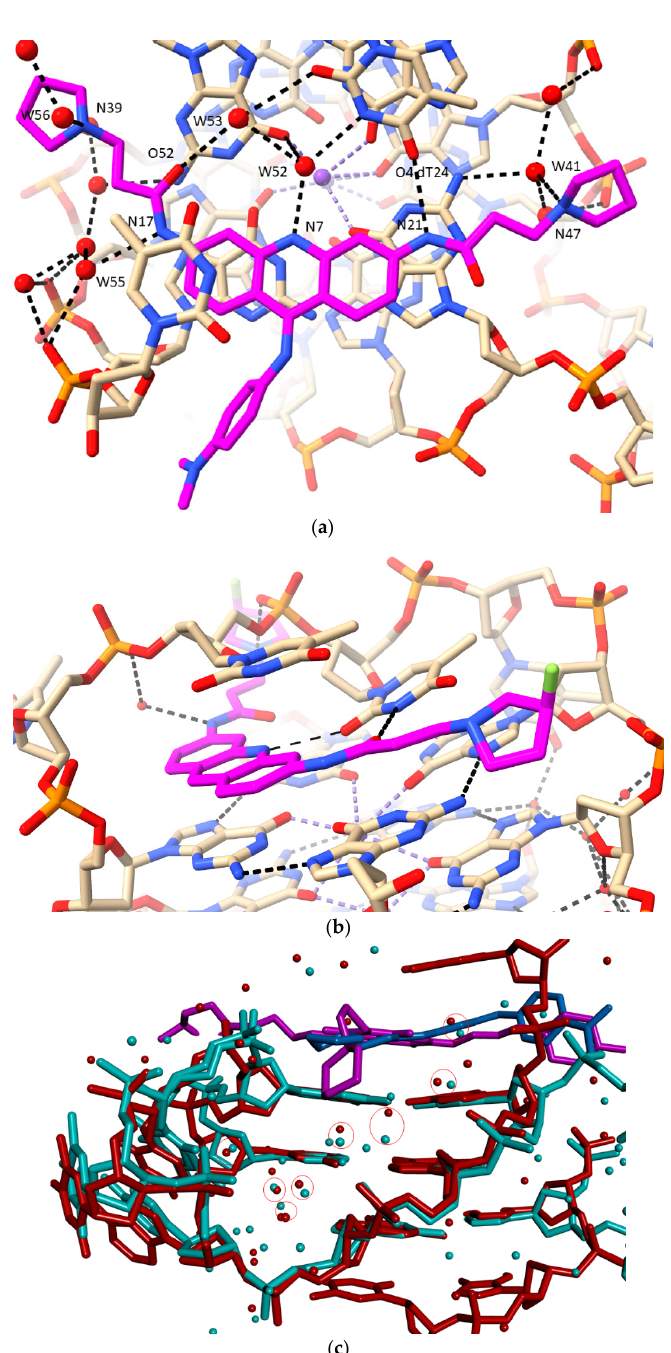
Figure 5. ( a ) View of the BRACO19 complex with a human telomeric bimolecular G-quadruplex, as observed in the crystal structure PDB id 3CE5 [74], projected onto the acridine plane. The carbon atoms of the ligand are colored magenta and water molecules are colored as red spheres. Hydrogen bonds are shown as dotted lines. Some water molecules not directly involved in ligand interactions have been omitted from this view to enhance clarity. ( b ) View of the complex involving a disubsti- tuted acridine with a fluorine atom attached to each terminal side chain pyrrolidino ring, bound to an Oxytricha nova bimolecular G-quadruplex [100]. Color coding is as in other figures, with the flu- orine atoms colored yellow. ( c ) Overlay of structures 3UYH (G-quadruplex in cyan and MM41 in magenta) and 3CE5 (G-quadruplex in red and BRACO19 in dark blue), superimposed on the G- quartets, viewed into groove 1 of the 3UYH structure. Water molecules in the groove are colored as in their G-quadruplex structures. Those water molecules in the two structures that are < 1.0 Å dis- tance to each other are enclosed in red circles. Removal of the water molecules from this structure followed by energy minimiza- tion, resulted in movement of the acridine by ca 2.5 Å, enabling the acridine ring nitrogen atom to directly contact the thymine ring substituents. Such an arrangement has been ob- served in the series of co-crystal structures [75] involving disubstituted acridines with the bimolecular anti-parallel GQ from Oxytricha nova (Table 2). These structures, exemplified by the two high-resolution structures [100] with fluorine substituents in the pyrrolidino side chains, have direct O 2 thymine and N3 hydrogen-bond contacts with the acridine ring